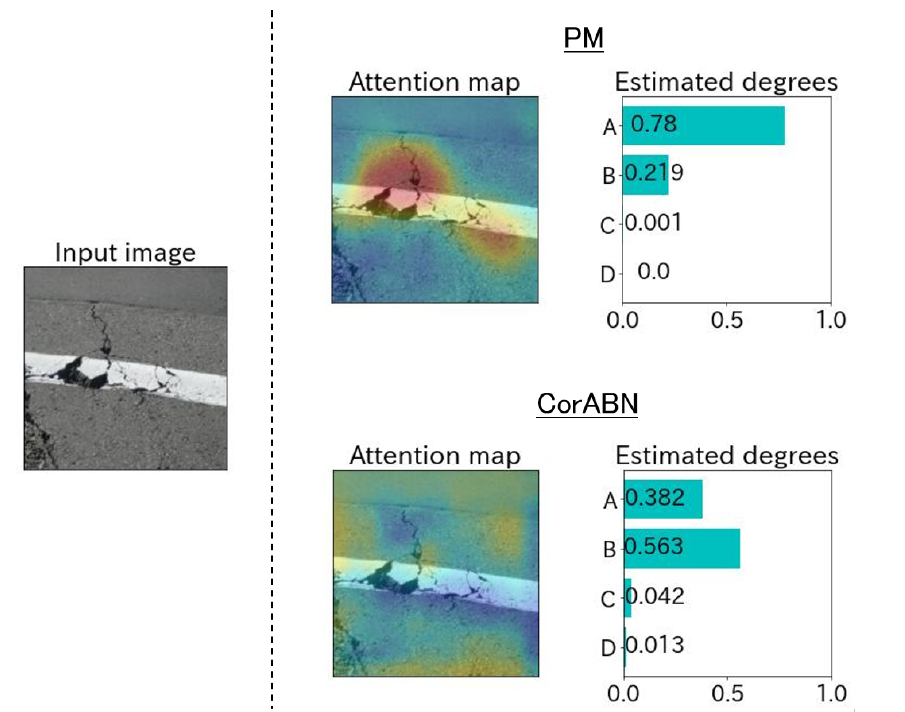
Figure 4. Estimated example at the degradation degree A for the distress type of